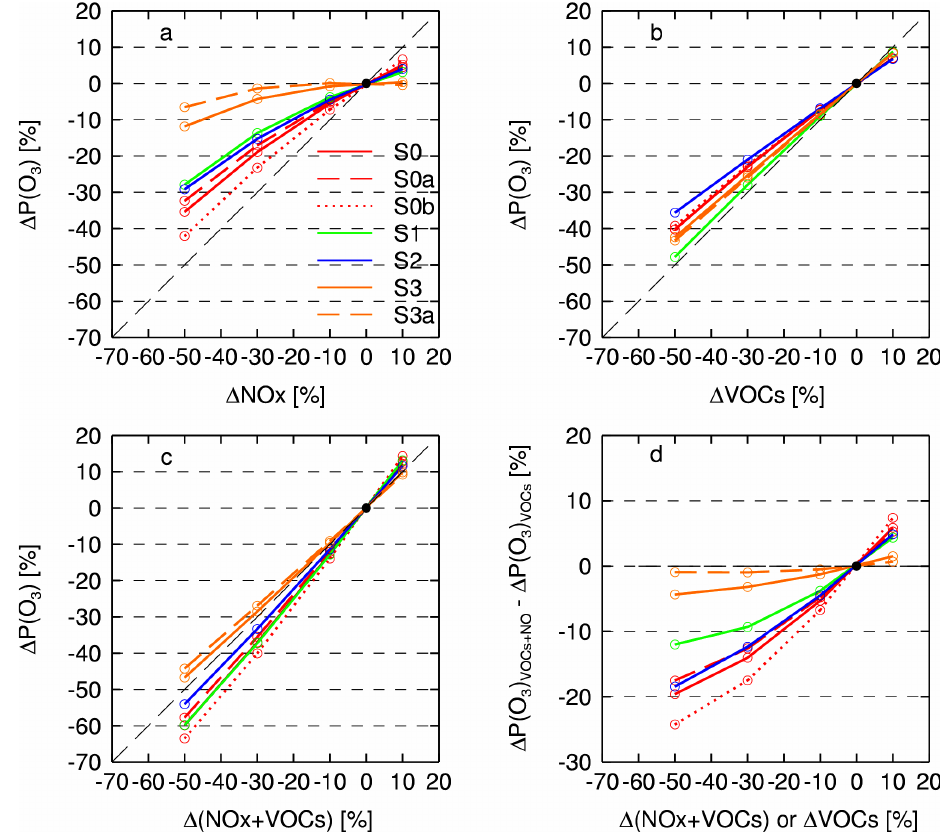
Fig. 9. Changes of O 3 production ( 1 P(O 3 ) ) as a function of NO x , VOCs, and both under different scenarios in Table 1.